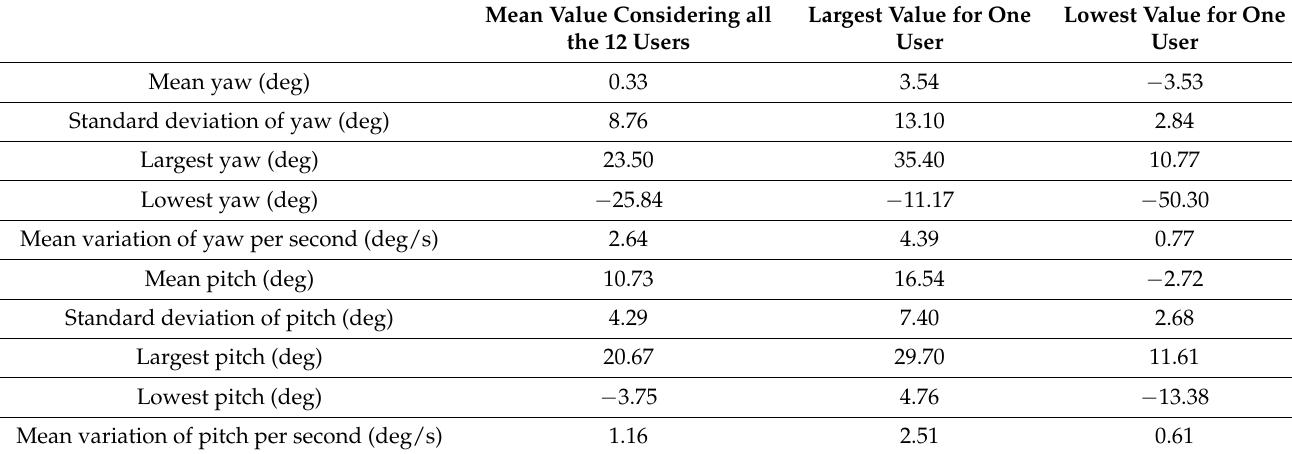
Table 1. Statistics about yaw and pitch obtained from Kinect.